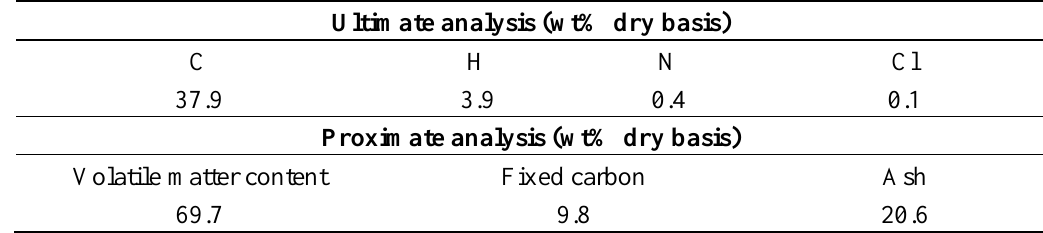
Table 1. Characterization of rice husk feed